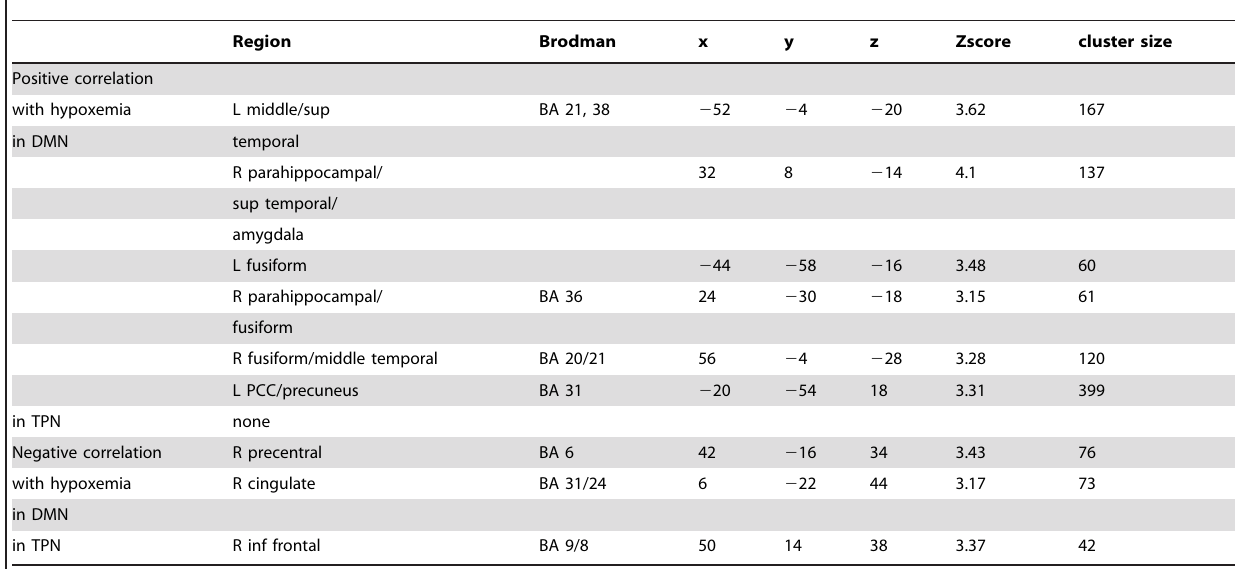
Table 5. Effects of nocturnal hypoxemia on cerebral activation in OSAS patients: cerebral regions showing significant positive correlation between the duration of nocturnal hypoxemia and effects of task load in DMN (ie, regions where increased duration of nocturnal hypoxemia correlates with less effective deactivation of DMN regions with increasing task load; MNI coordinates, corrected for multiple comparisons, p =